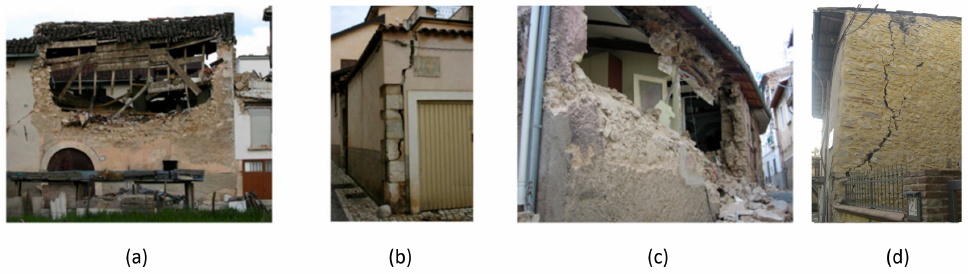
Figure 1. Examples of out-of-plane damage patterns from L’Aquila 2009 earthquake: ( a ) Out-of-plane mechanism in long walls. ( b ) Global overturning of external walls. ( c ) Overturning due to the lack of anchorage between walls and horizontal diaphragms. ( d ) Corner out-of-plane mechanism [66]. (Sources: Dr. Javier Ortega, Prof. Hugo